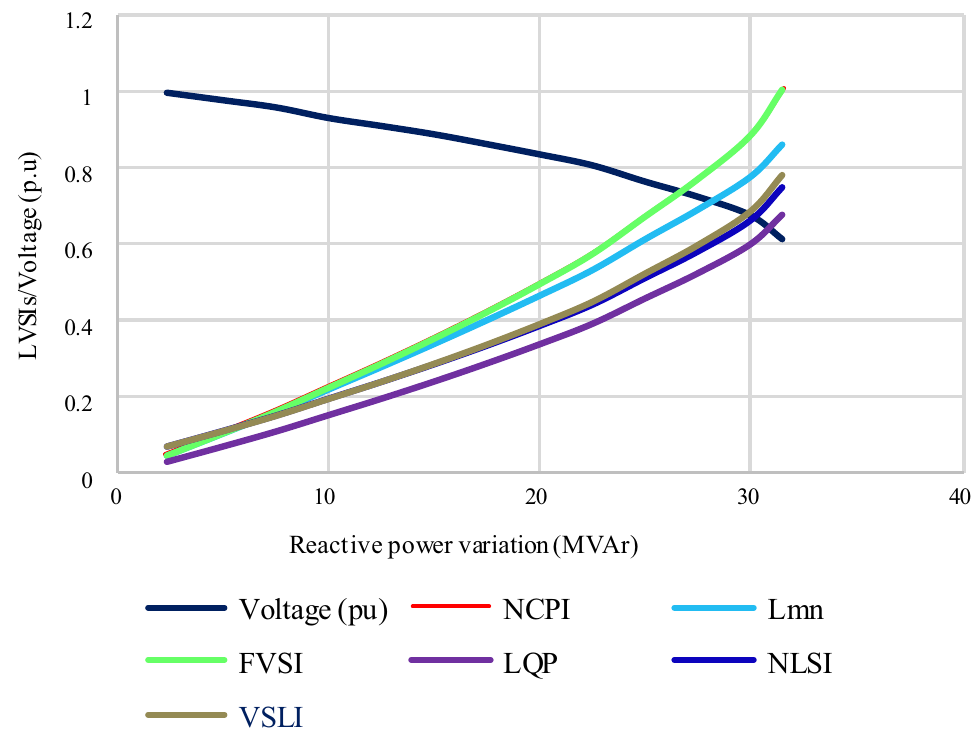
Fig. 8 Variations of line voltage stability indices (LVSIs) for branch 26–25 during reactive power variations at bus 26